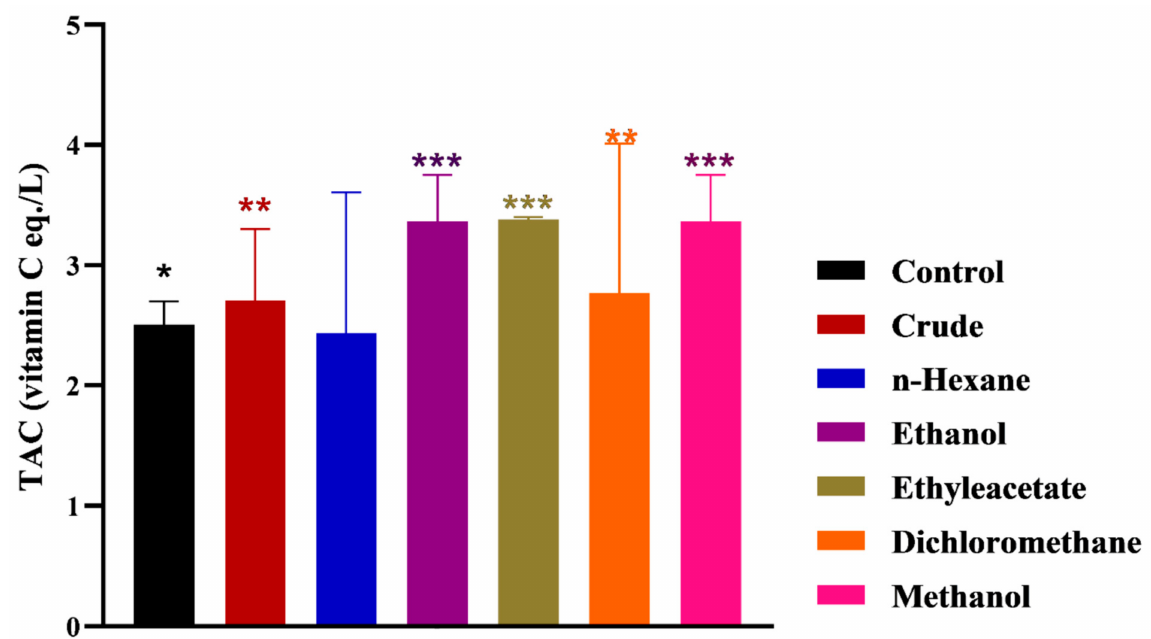
Figure 5. Effects of M. oleifera on total antioxidant capacity following sciatic nerve lesion. *, **, *** show the significance of results